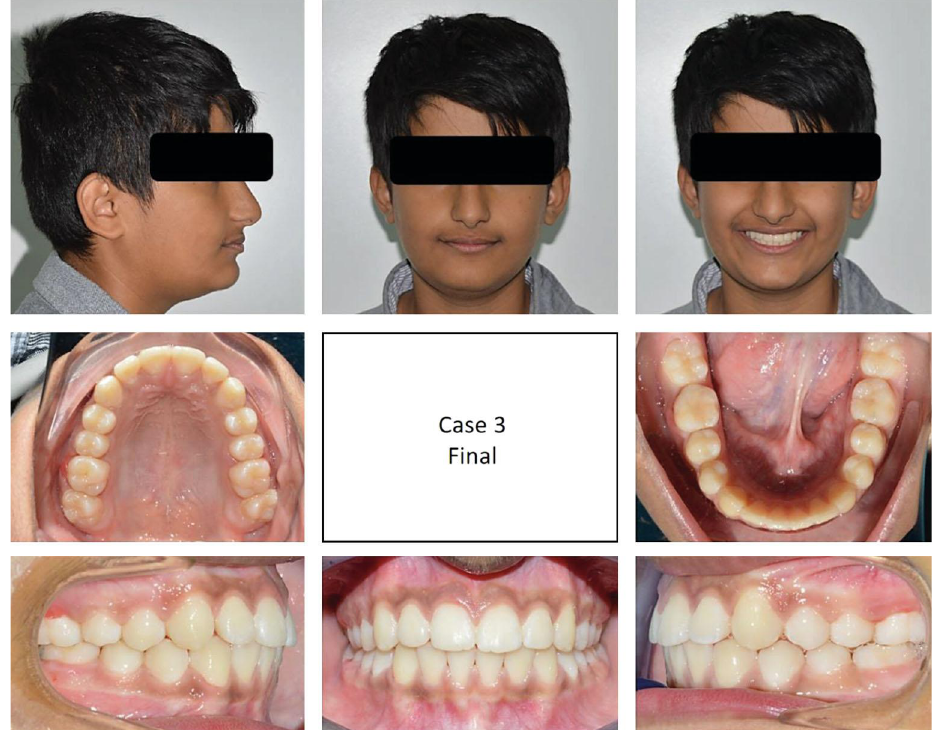
Figure 17: Posttreatment extraoral and intraoral photographs of the patient.